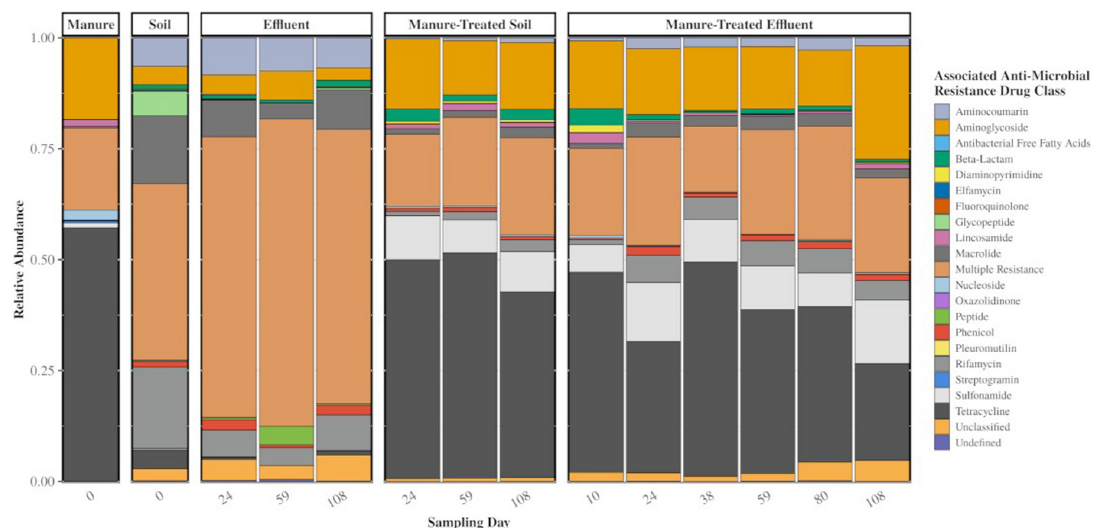
Fig 3. Relative abundance of ARGs (averaged for four replicate samples at each time point) categorized by associations with antibiotic resistance class in the CARD database. Samples are displayed in groupings by sample type. “Multiple Resistance” for ARG classification refers to any gene that has been annotated as associated with more than a single antibiotic class.